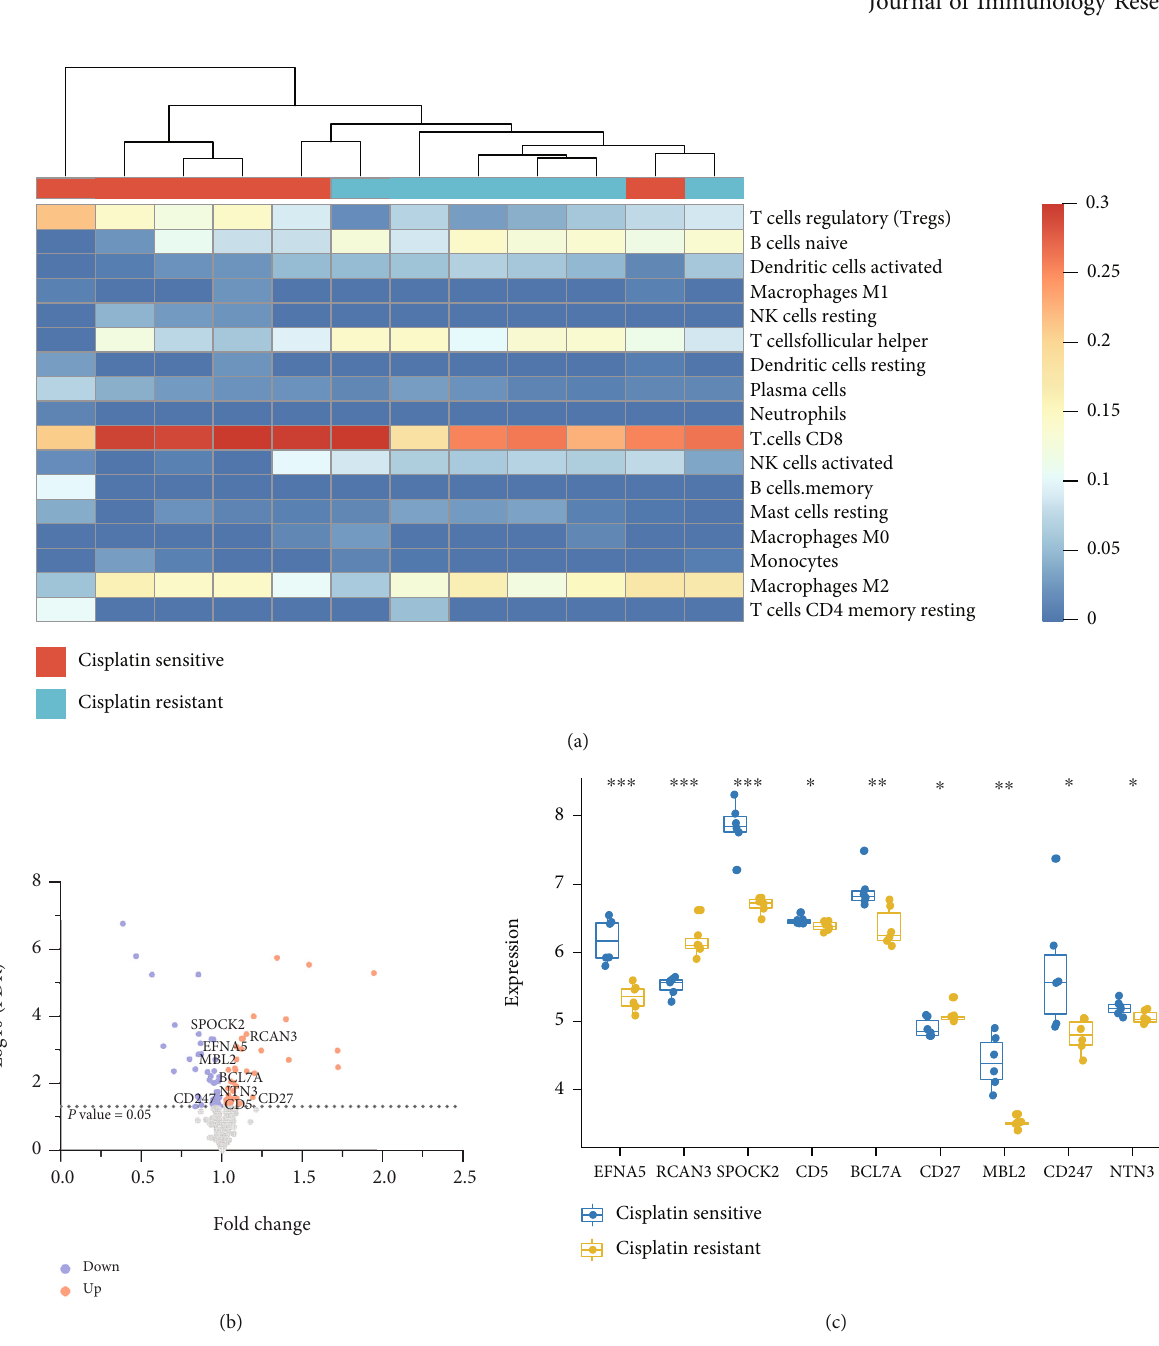
Figure 1: The immune microenvironment of cisplatin-resistant and cisplatin-sensitive OV groups. (a) The immune cell scores of cisplatin- resistant and cisplatin-sensitive groups. The dendrogram showed the hierarchical clustering results of cisplatin-resistant and cisplatin- sensitive groups. (b) Di ff erentially expressed immune genes between cisplatin-resistant and cisplatin-sensitive groups. The red and blue points represented upregulated and downregulated genes, respectively. The texts indicated the symbols of nine Treg-related genes. (c) The expression pro fi les of nine Treg-related genes in cisplatin-resistant and cisplatin-sensitive